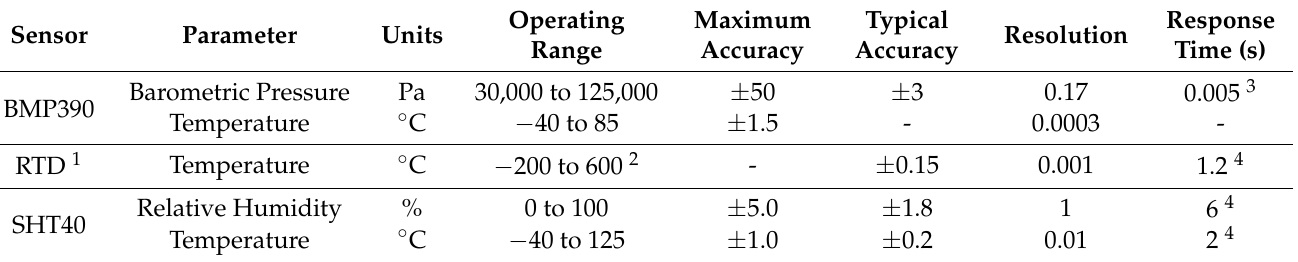
Table 1. Nominal specifications for pressure, temperature, and relative humidity sensors provided by sensor manufacturers. Maximum accuracy encompasses the entire operating range, while typical accuracy is either a limited range or at standard ambient